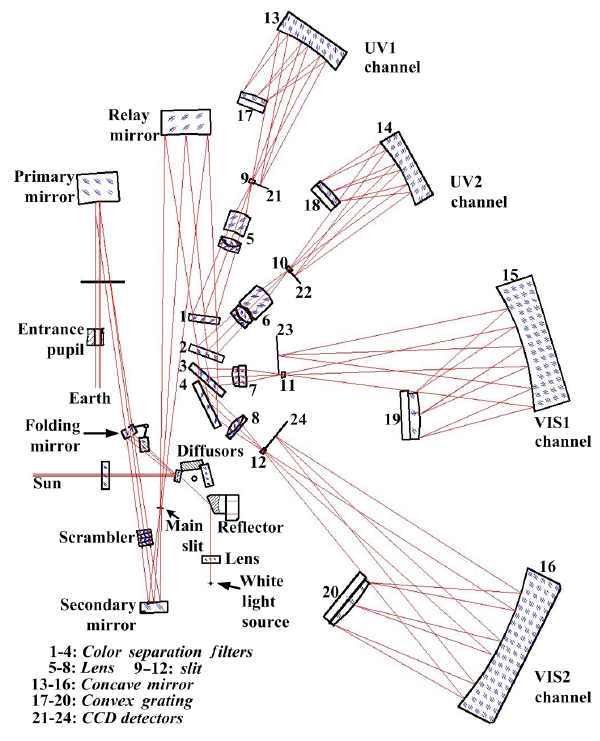
Figure 1. Optical layout of the